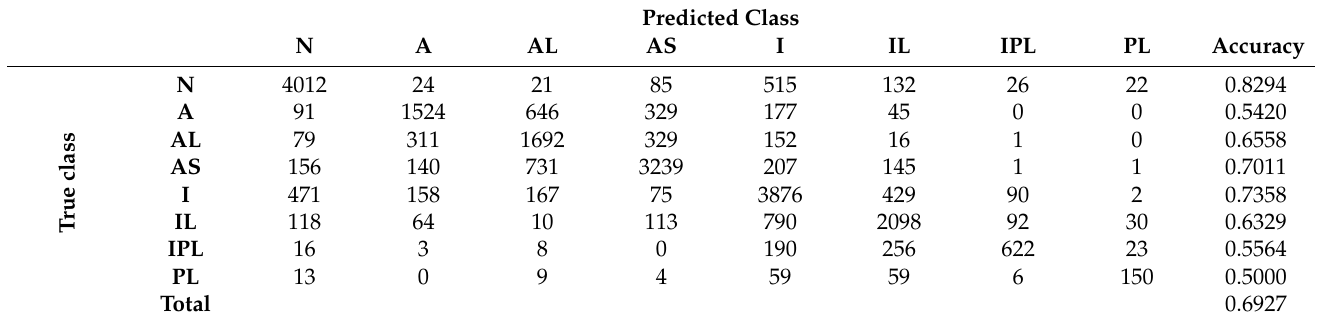
Table 8. Confusion matrix for MI localization and classification accuracy for each class in Setting